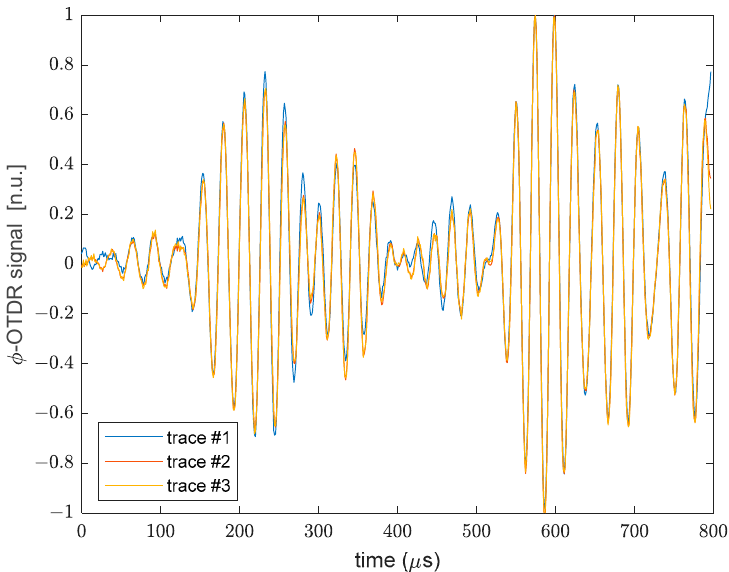
Figure 5. Normalized φ -OTDR acquired along the OFS1 fiber strand over three consecutive measurements.